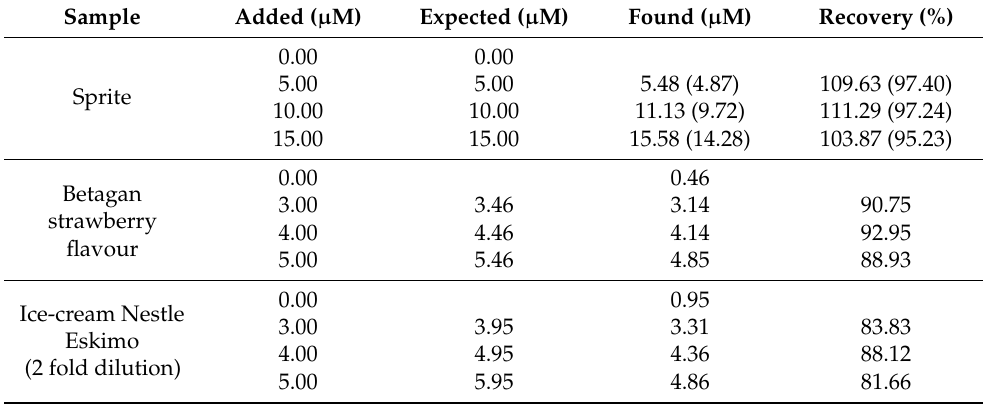
Table 8. Performance of modified sensor for carminic acid determination in real